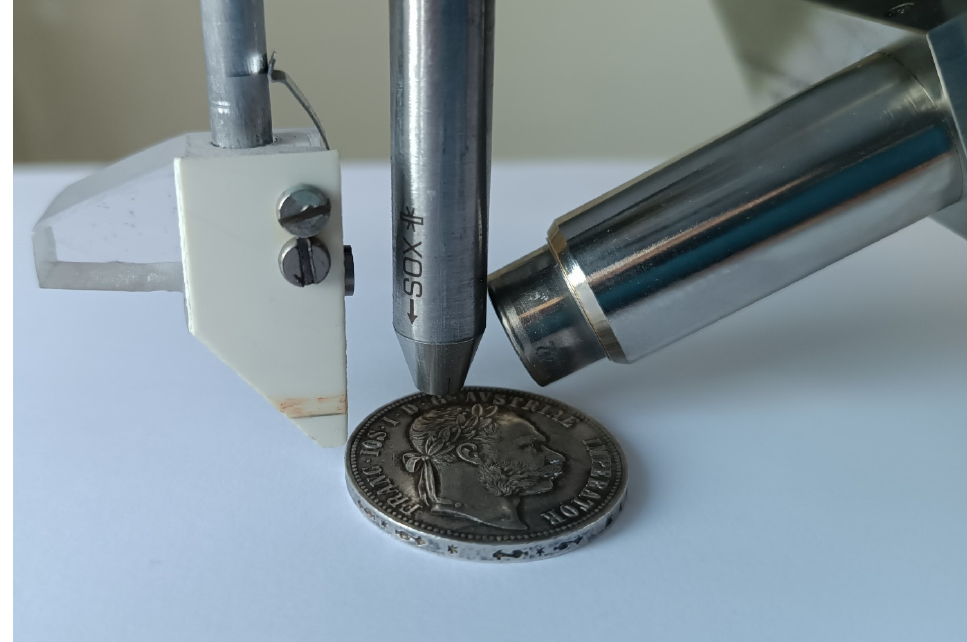
Figure 1. X-ray fluorescence system consisting of SDD detector ( right ), X-ray tube with polycapillary optics device ( middle ), and distance bar ( left ) with a coin as a specimen.